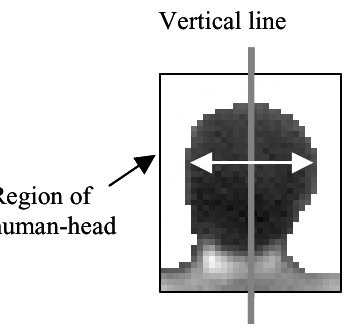
Fig. 6. Symmetricity of brightness pattern around vertical line of a human